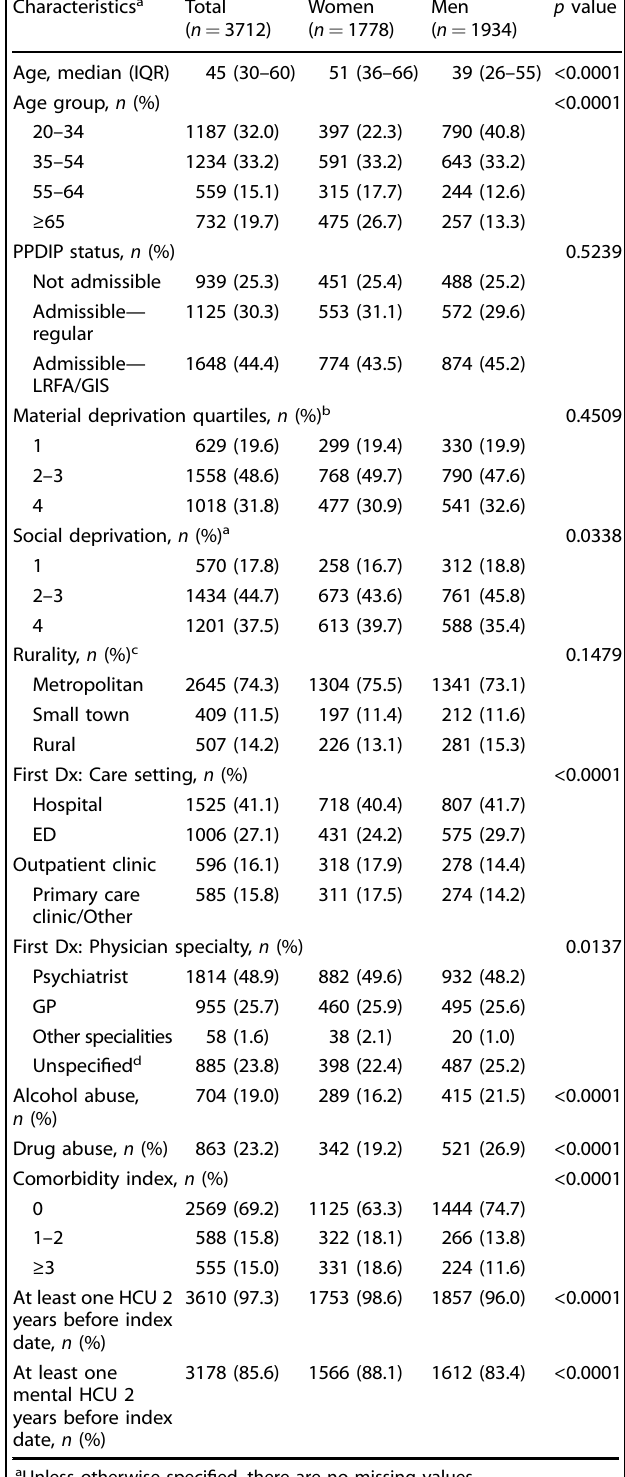
Table 1. Characteristics of the study population by sex ( n = 3712).